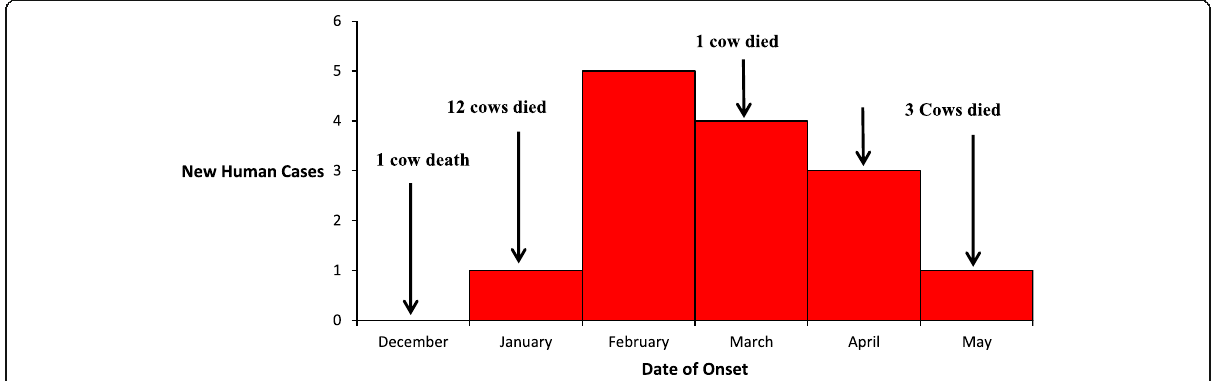
Fig. 3 Epidemic curve of case-persons with cutaneous anthrax in Rhino Camp, Arua District, Uganda, 2018